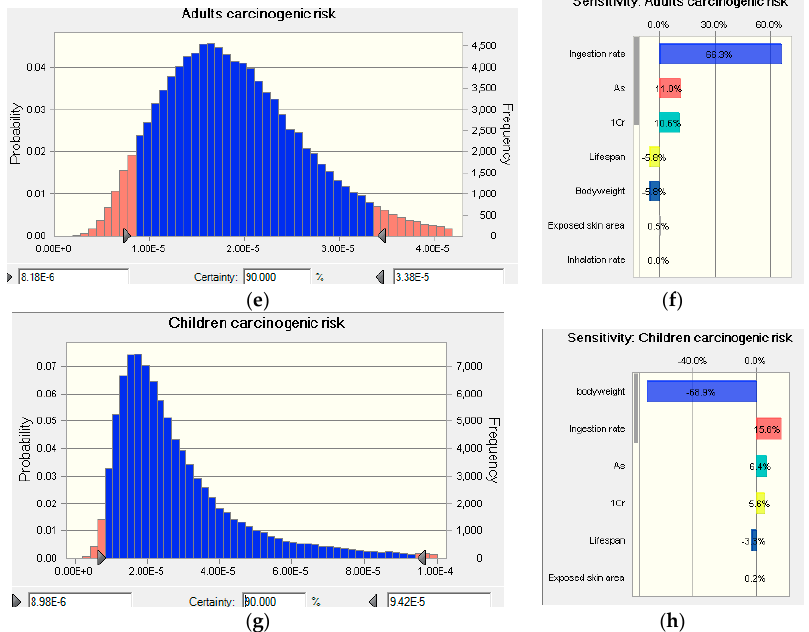
Figure 7 . Probability distribution of the noncarcinogenic ( a – d ) and carcinogenic ( e – h ) health risks of metals and the uncertainty analysis for adults ( a , b , e , f ) and children ( c , d , g , h ).